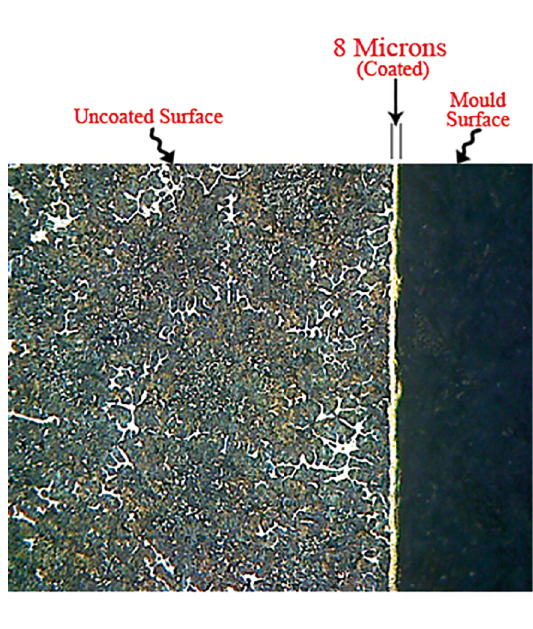
Figure 9. Metallurgical Microscope (Metscope-1) image of coating thickness of Ni/nano- Al specimen.